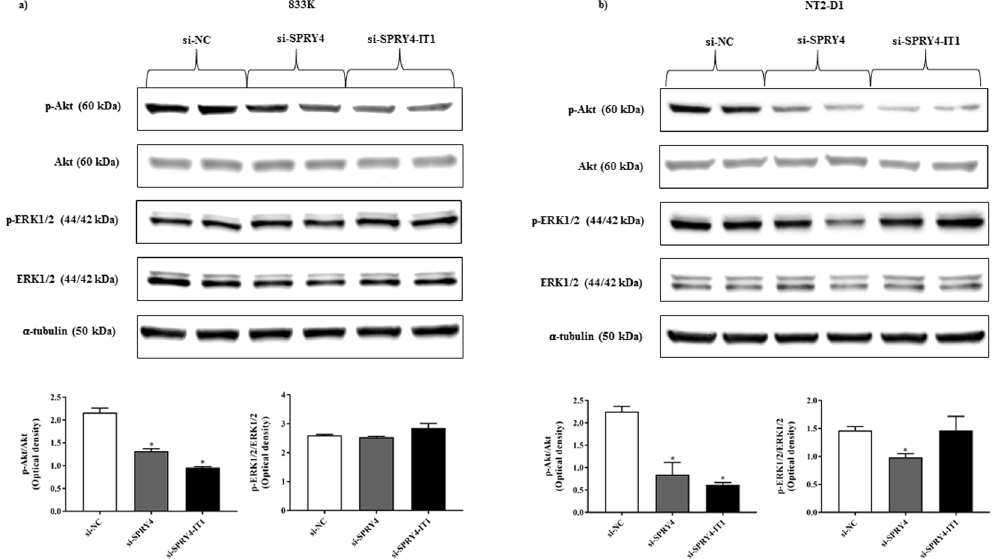
Figure 5. Effects of SPRY4 and SPRY4-IT1 knockdown on the activation of PI3/Akt and MAPK/ERK1/2 pathway. Western blot was performed to investigate the phosphorylation of Akt and ERK1/2 after knockdown of SPRY4 and SPRY4-IT1 . After knockdown of SPRY4 and SPRY4-IT1 , Akt phosphorylation was significantly inhibited in 833 K ( a ) and NT2-D1 ( b ) cells, particularly, inhibition of Akt phosphorylation was quite substantial in NT2-D1 cells by both SPRY4 and SPRY4-IT1 knockdown. However, phosphorylation of ERK1/2 only showed a weak but significant inhibition in NT2-D1 cells after the SPRY4 knockdown. Akt and ERK1/2 were used as endogenous controls, and α -tubulin was used as a loading control. The bar graphs show the corresponding densitometric analyses of the western blots where the ratio of p-Akt/Akt, and the ratio of p-ERK1/2/ERK1/2 were calculated after normalising with α -tubulin. Samples were loaded as independent duplicates. The cropped blots are used in the figure, and full-length blots are presented in Supplementary Figs S3, 4. The experiments were repeated at least three times, and a representative experiment is shown. t -test: Control vs siRNA, mean ± SD, statistical significance p <